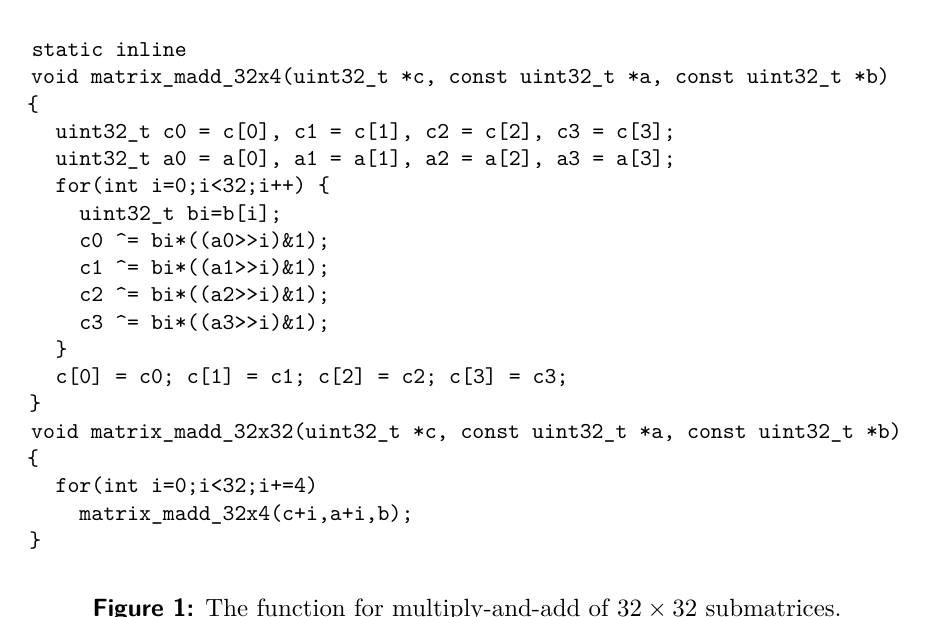
Figure 1: The function for multiply-and-add of 32 × 32 submatrices.